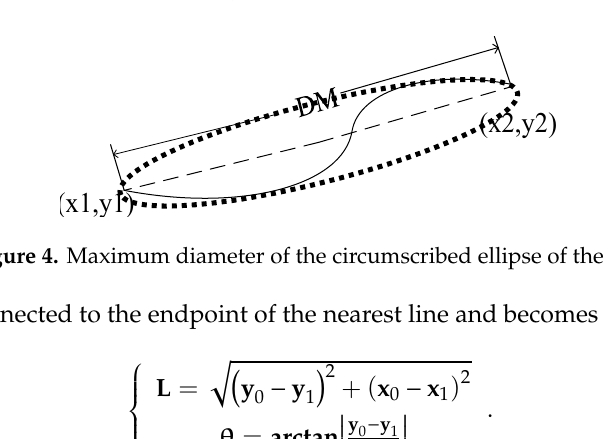
Figure 5. Breakpoint connection process.